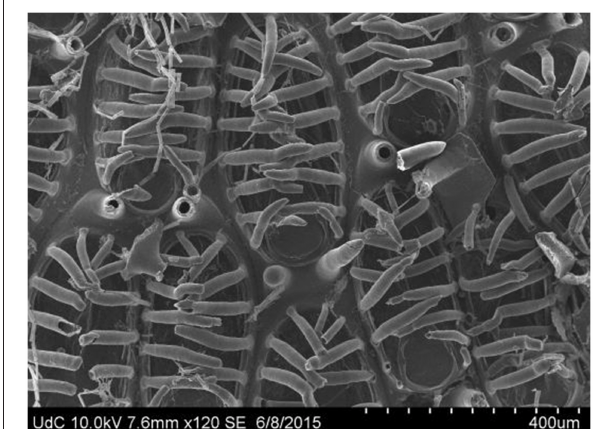
FIGURE 2 | Bryozoa (Electra angulata Levinsen, 1909) fixed on a Mediterranean floating plastic collected in the Northern